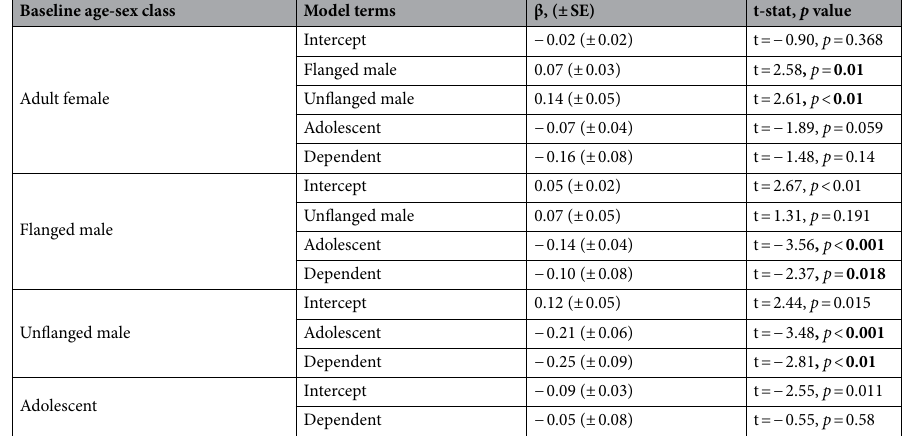
Table 1. The relationship between ELBM, age-sex class, and FAI using GAMMs. β coefficients presented are for the age-sex class in model term relative to the baseline age-sex class in the first column. Significant p values are highlighted in bold. Age-sex class (fixed effect), FAI (smoothed), and Individual ID (random effect) were included in each model (r 2 adj = 0.09). FAI was a significant predictor in all models (F (5.094) = 13.6, p <